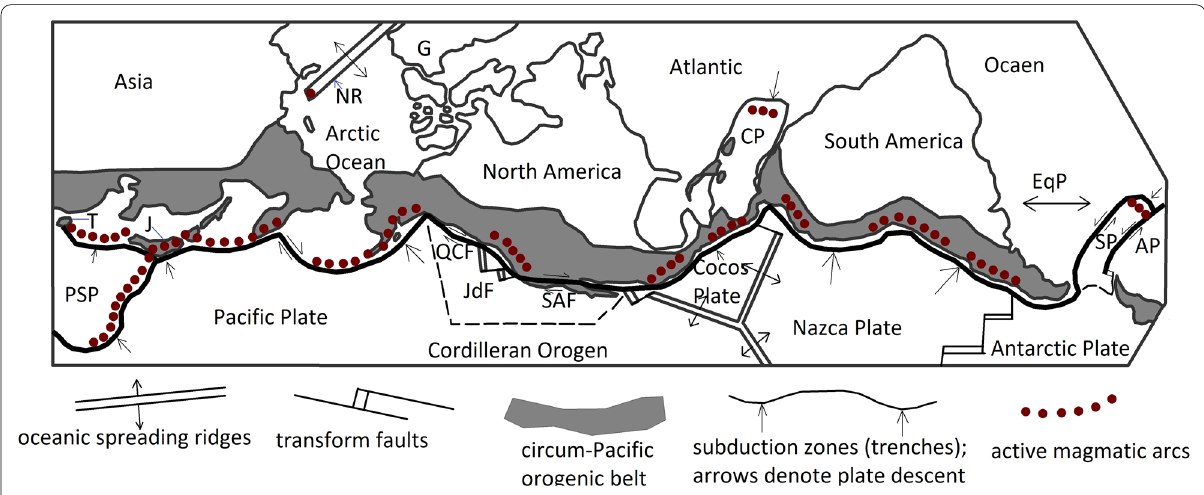
Fig. 1 Position of the Cordilleran orogen of western North America along the Circum-Pacific orogenic belt (Dickinson,